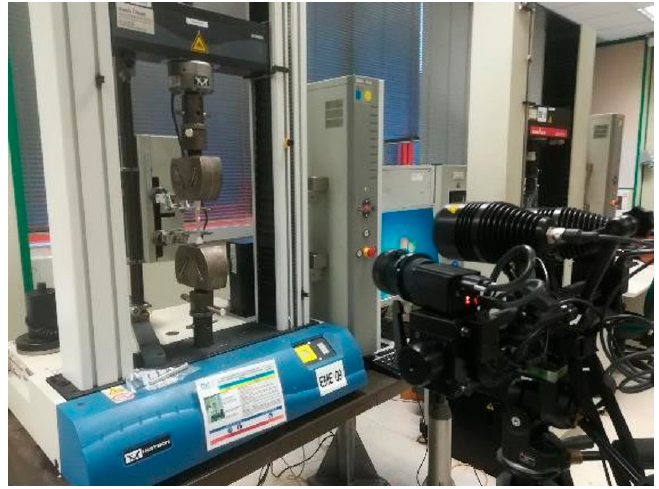
Figure 8. Tested samples after failure.